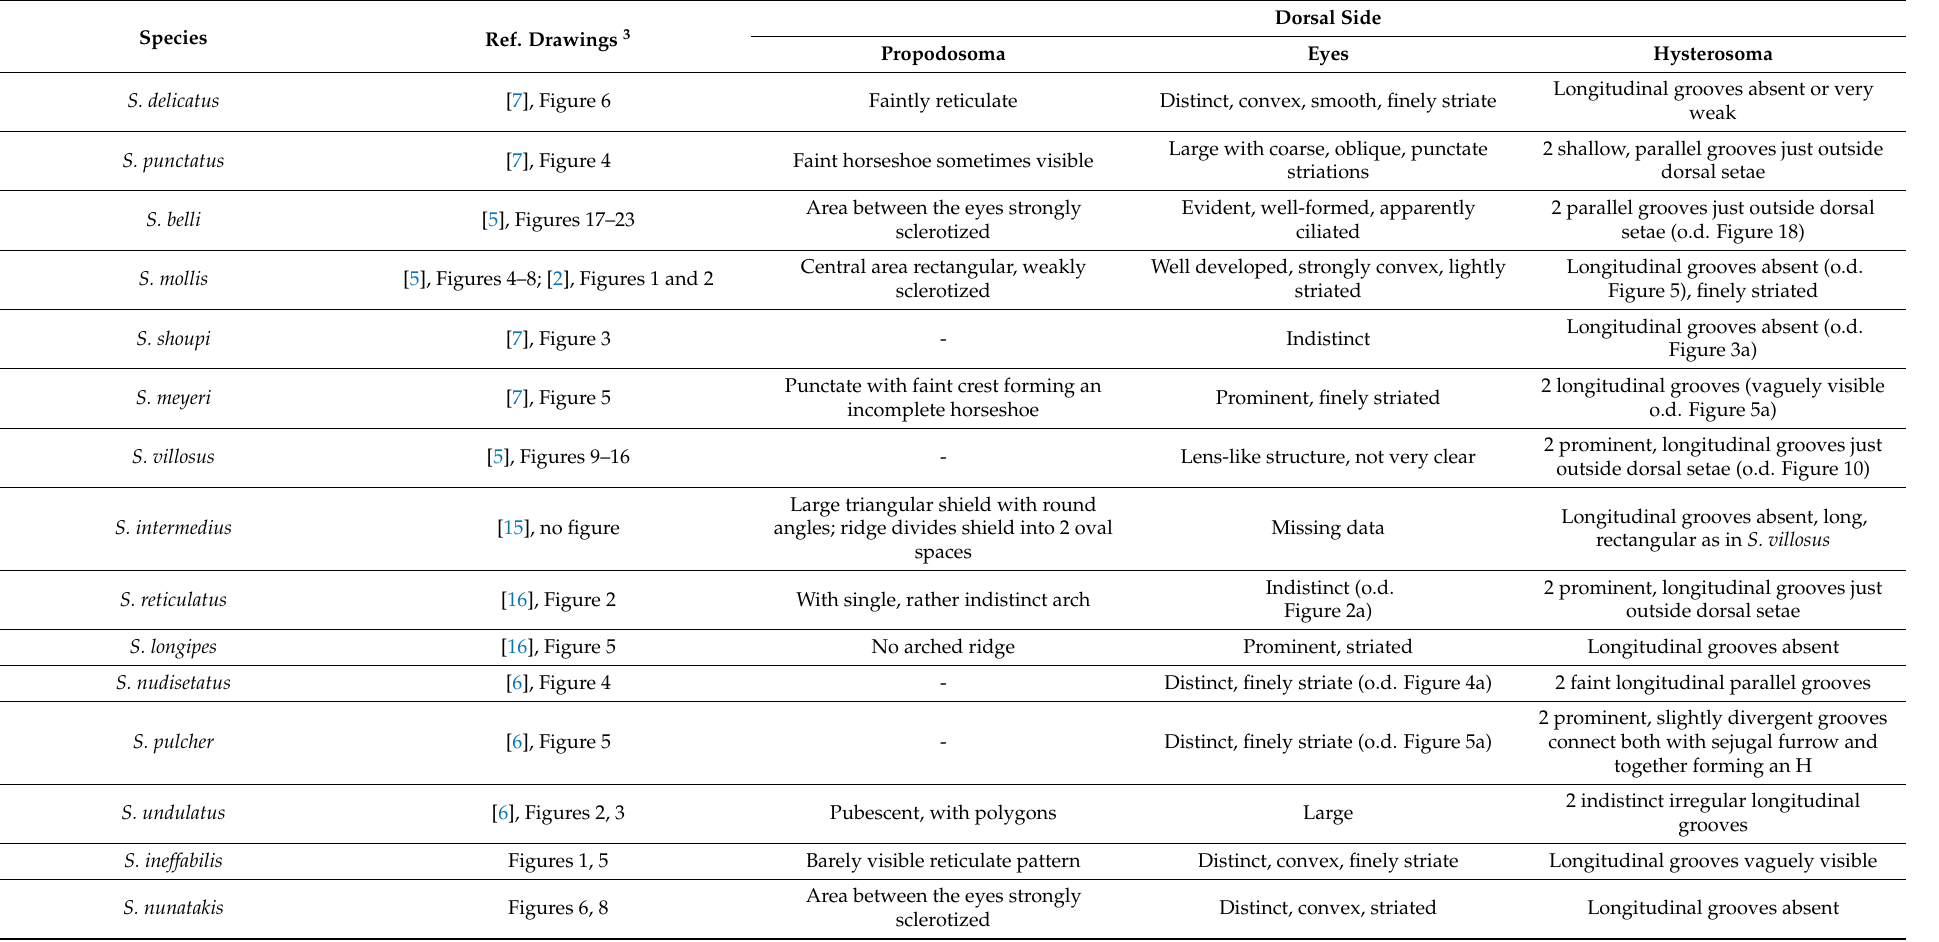
Table A3. Synoptic table of the Antarctic and sub-Antarctic Stereotydeus species with particular attention to the morphological characteristics useful for the identification of the different species. When a characteristic was not in the main text of the description, the reference drawings were used to extrapolate the data and mentioned in the table; on drawing